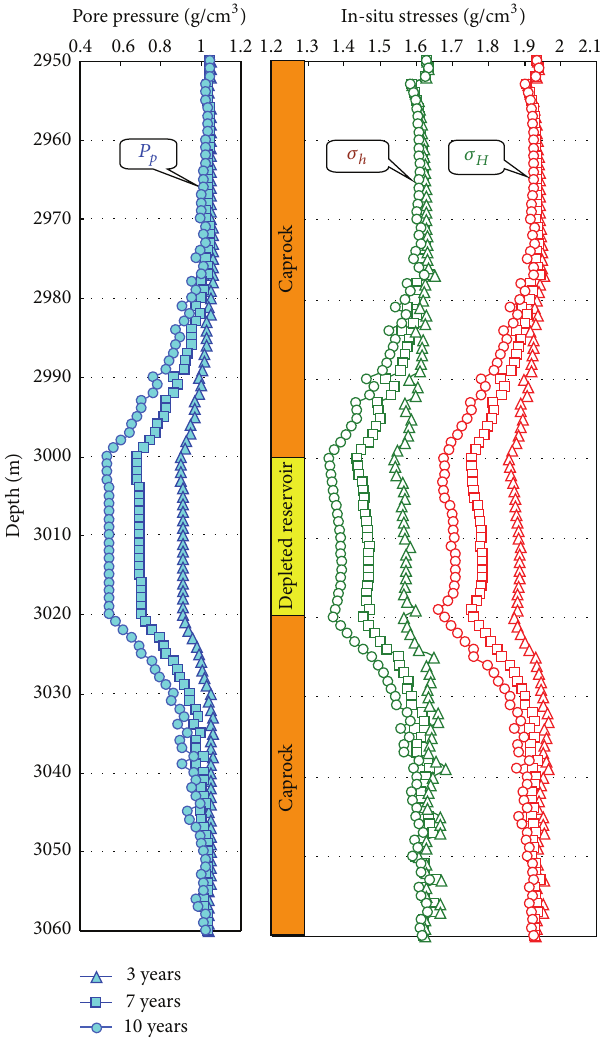
Figure3:Influenceofdevelopmentonthein-situstressesofcaprock and reservoir with different development